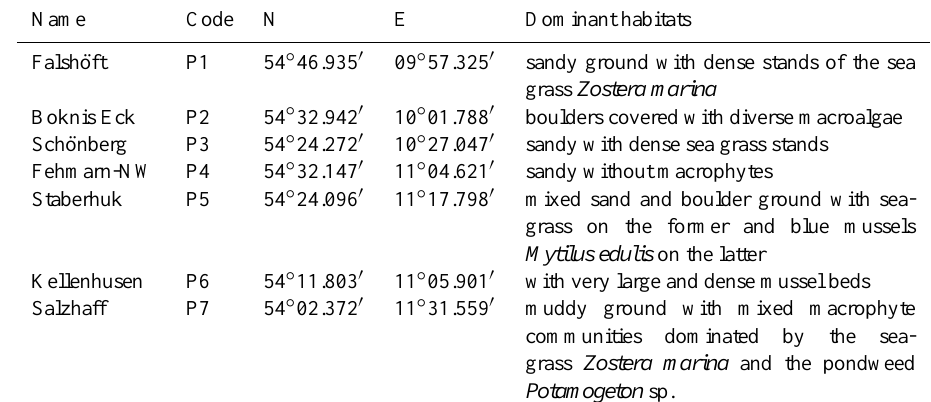
Table 1. Coordinates and habitat characteristics of the stations sampled during this survey.